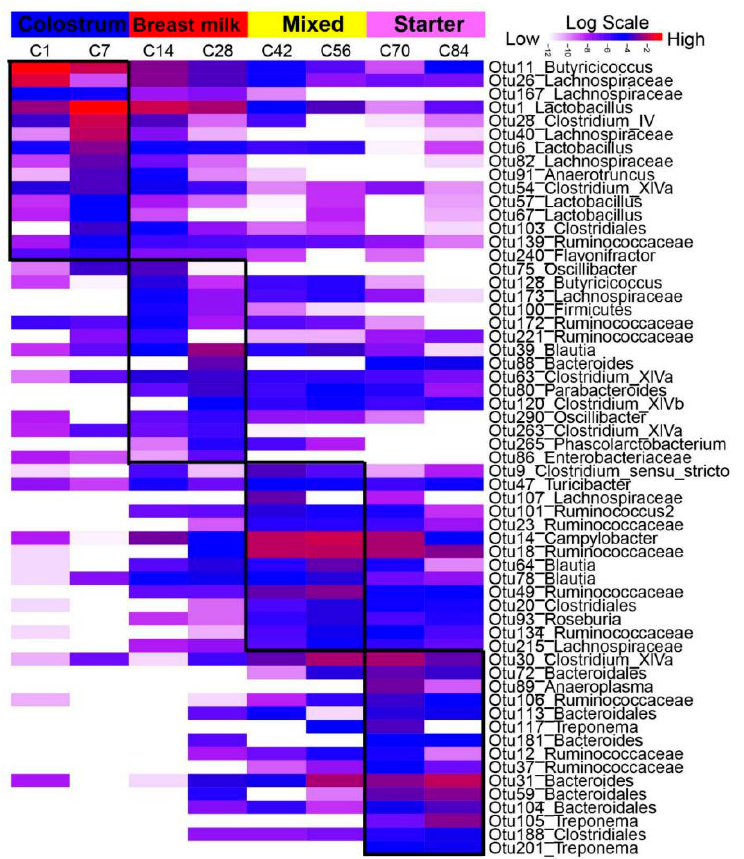
Figure 5. The colon stage-associated bacteria identified by LEfSe analyses. Heat map shows the average relative abundances of ages on a log scale. OTUs in this graph were statistically significant ( p < 0.05) and had an LDA Score > 2, which was considered a significant effect size. The Log-scaled relative abundance heatmap of stage-related OTUs screened in colon contents. The color of cells from white to red corresponds to the relative abundance of OTUs from low to high. The growth phases of colostrum (d1 and d7), breast milk (d14 and d28), mixed feeding (d42 and d56) and starter feeding stages (d70 and d84) were labeled with different colors. C1 = colon d1, the rest can be deduced by analogy.